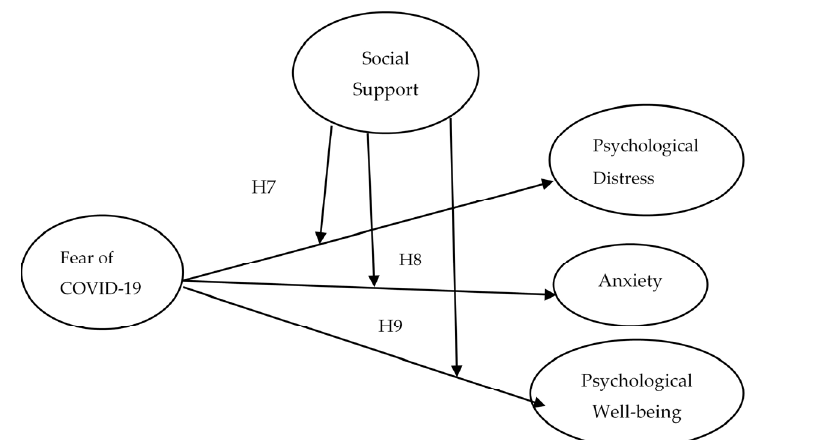
Figure 1. Conceptual Model of the study.